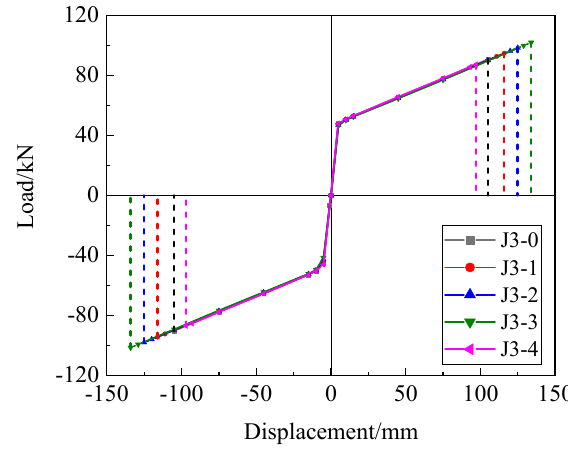
Figure 27. Envelope curves of joints.